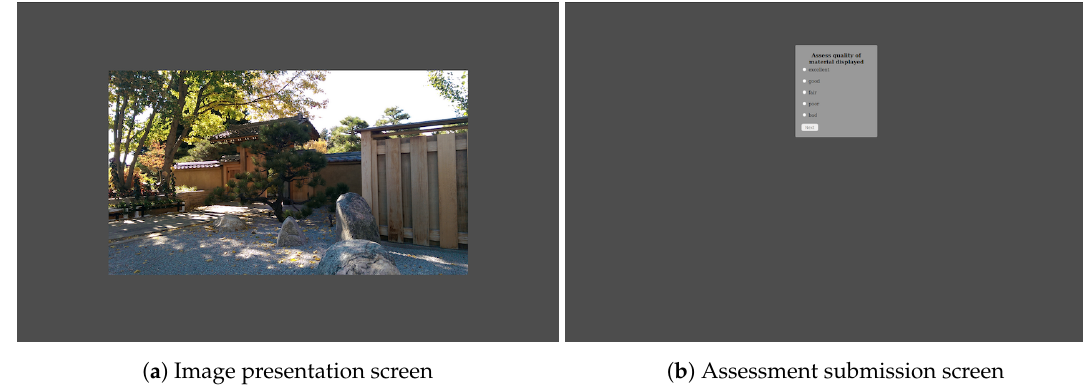
Figure 8. Two screens from our web-based software interface for conducting the subjective